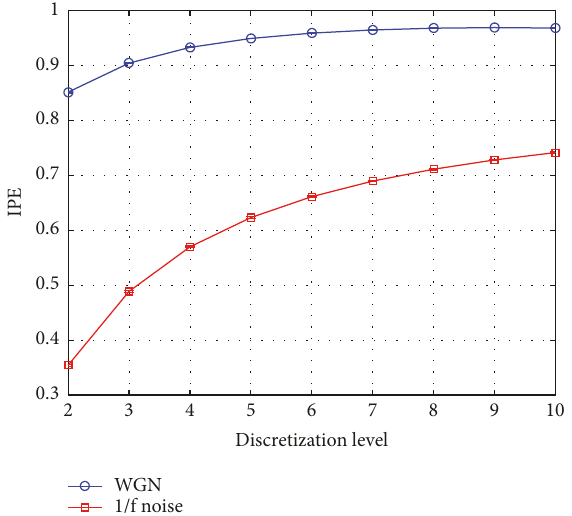
Figure 4: Error bar plot of IPE over a varying discretization level.